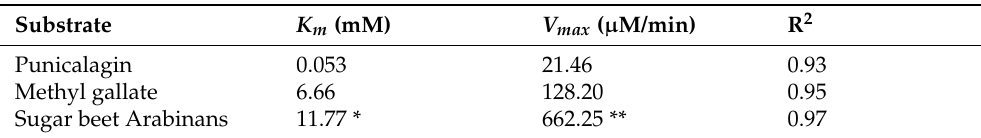
Table 2. Kinetic parameters in the hydrolysis of punicalagin, methyl gallate, and sugar beet arabinans by